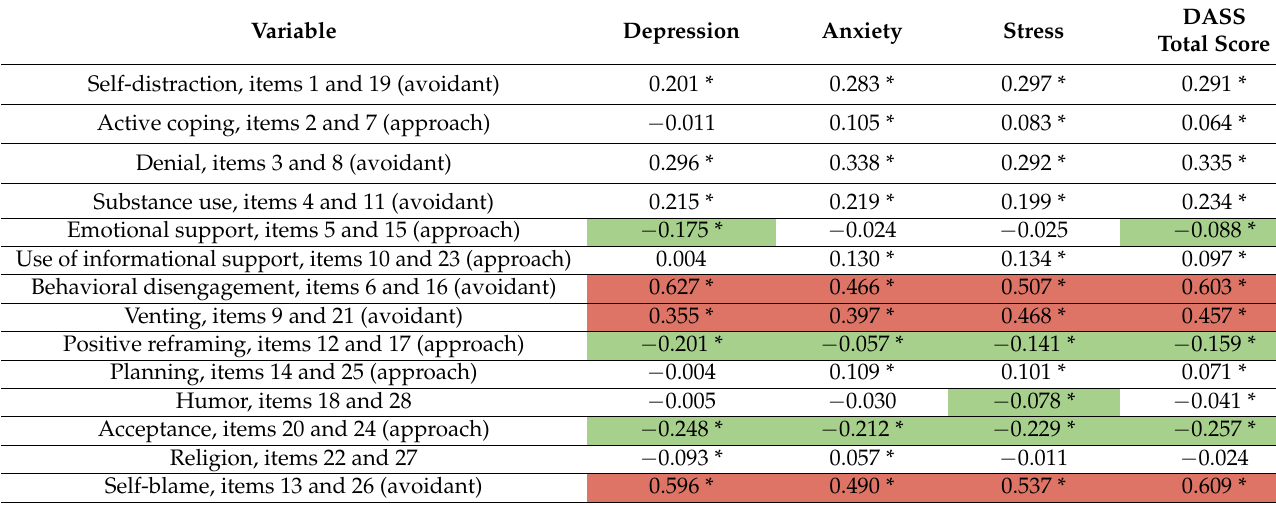
Table 4. Correlation analysis results of COPE subscales, DASS subscales, and total